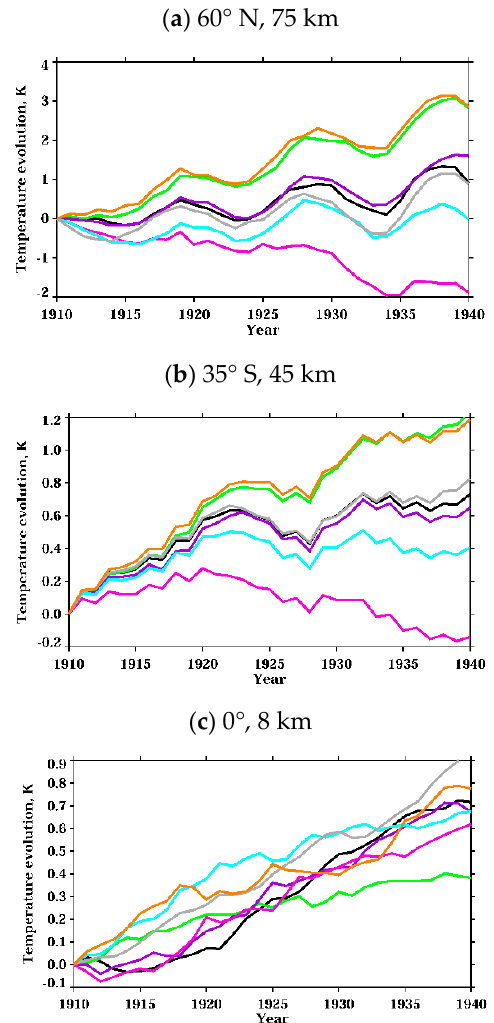
Figure 6. The evolution of annual and zonal mean temperature since the 1910. ( a ) In the northern midlatitude mesosphere panel; ( b ) in the upper stratosphere over southern midlatitudes panel; and ( c ) in the tropical middle troposphere panel. The lines are black for ALL, violet for noEPP, magenta for fixUV, light blue for fixVIS/IR, green for fixGHG, orange for fixWMGHG, and grey for noVOL experiments.